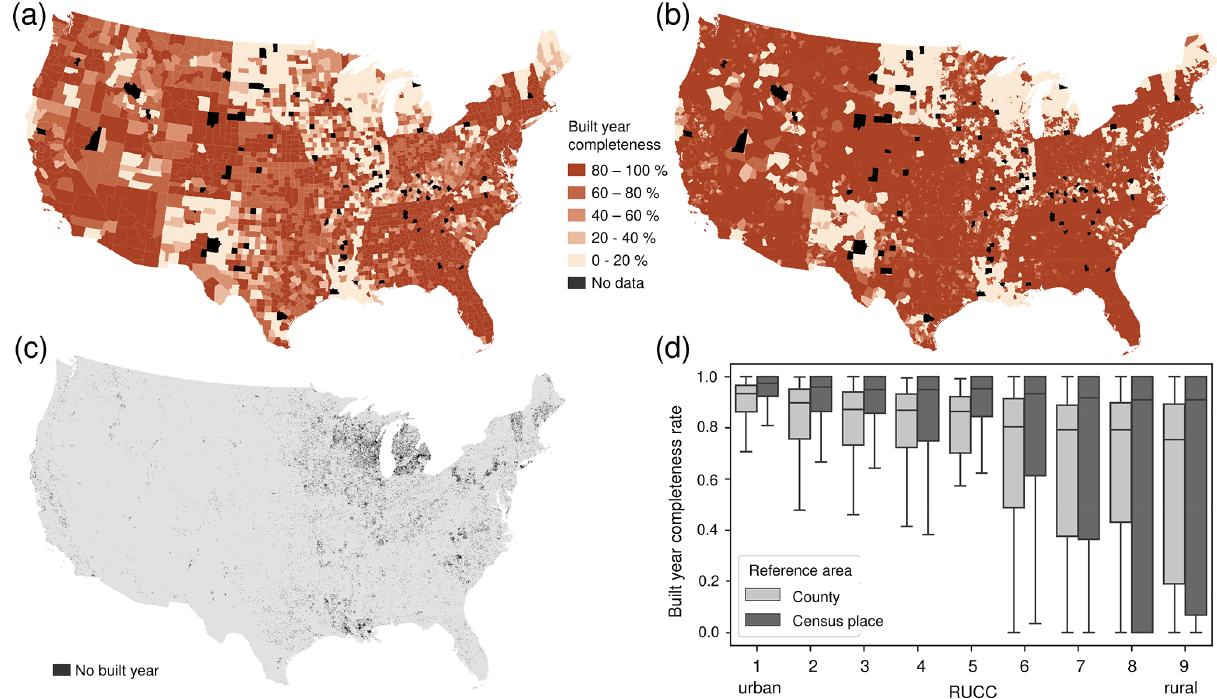
Figure 6. Data completeness analysis. (a) Built-year county-level completeness and (b) census-place-level completeness, (c) grid cells without built-year information, and (d) trends of built-year completeness across the rural–urban continuum. Census place boundaries shown in (b) are generalized using Thiessen polygons derived from place polygon centroids for readability